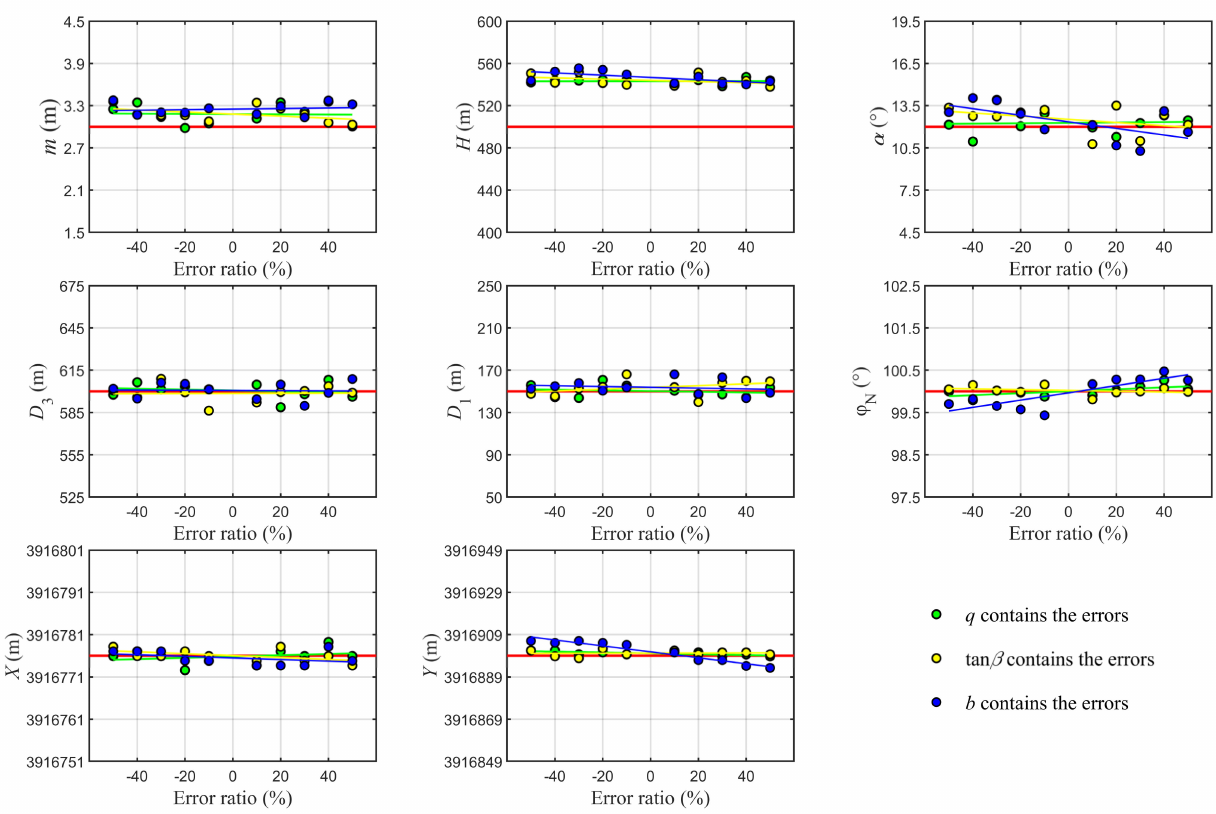
Figure 11. Goaf parameters retrieved when the initial model parameters of the PIM include errors. The yellow, green, and blue lines are the results of linear fitting; the red line indicates the simulated goaf